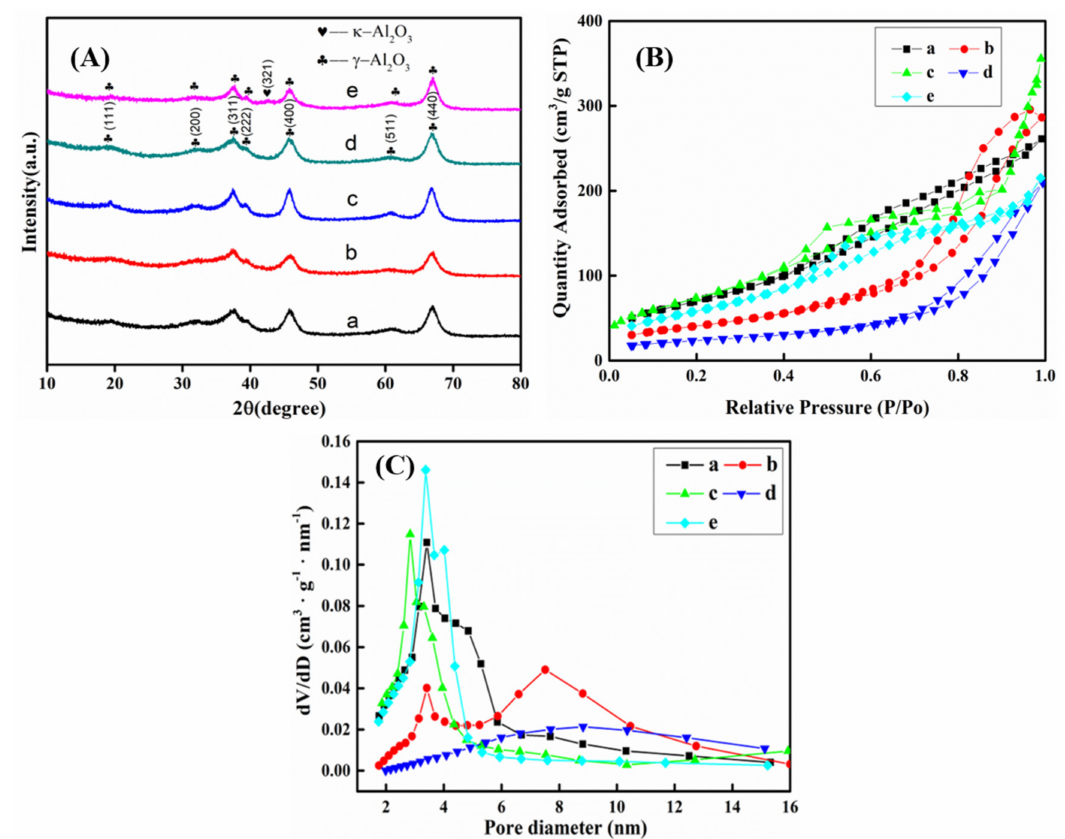
Figure 1. XRD pattern ( A ), nitrogen adsorption–desorption isotherms ( B ), and pore-size distribution curves ( C ) of the MA synthesized in various pH solutions and calcined at 500 ◦ C: (a) pH = 6; (b) pH = 8; (c) pH = 10; (d) pH = 12; (e) pH =